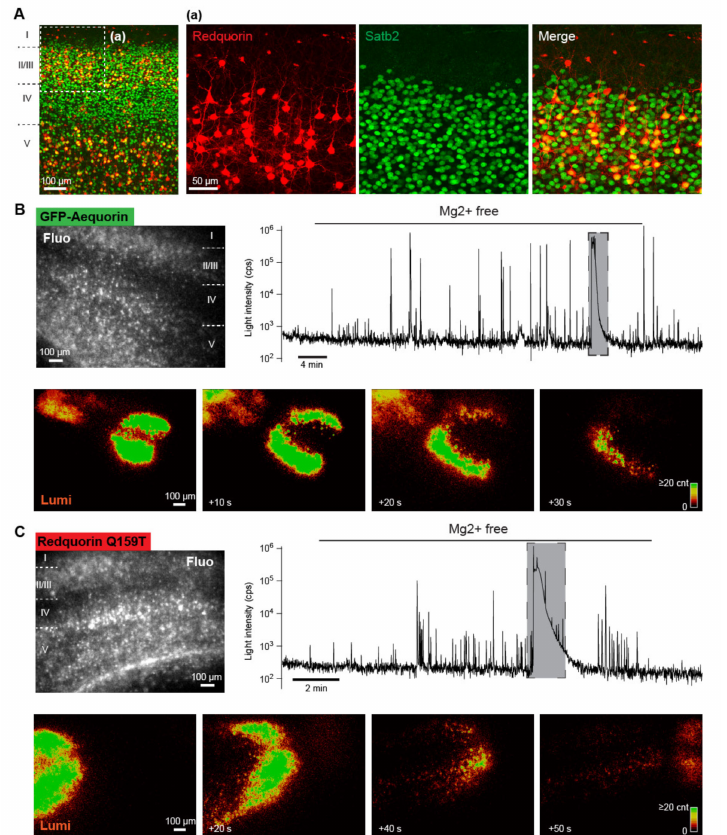
Figure 7. Ca 2 + imaging of mouse neocortical network activities with GA and RedquorinQ159T. ( A ) Confocal reconstruction of a neocortical slice expressing RedquorinQ159T after viral gene transfer. Redquorin-expressing cells were preferentially localized in layers II / III and V, and most exhibited the typical morphology of pyramidal neurons and were immunopositive for the marker of excitatory neurons Satb2. ( B , C ) Upper : Fluorescence images (Fluo) of neocortical slices expressing the indicated Ca 2 + sensor, and traces corresponding to whole-field bioluminescence recordings of the same slices. Note the logarithmic scale of light intensity. Lower : Bioluminescence images of the same slices showing intense bioluminescence waves corresponding to the large peaks on whole-field bioluminescence traces indicated by shadowed boxes. Note the slow propagation of the